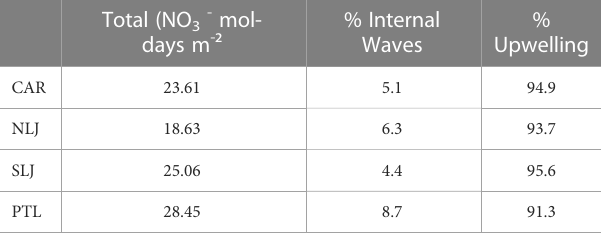
TABLE 2 Total nutrient exposure (NO 3- mol-days m -2 ) across the study year (24 Jun 2014 through 25 May 2015, n = 336 d) for sites at Cardiff (CAR), North La Jolla (NLJ), South La Jolla (SLJ), and Point Loma (PTL). % Internal % Total (NO 3 - mol- Waves days m - ²